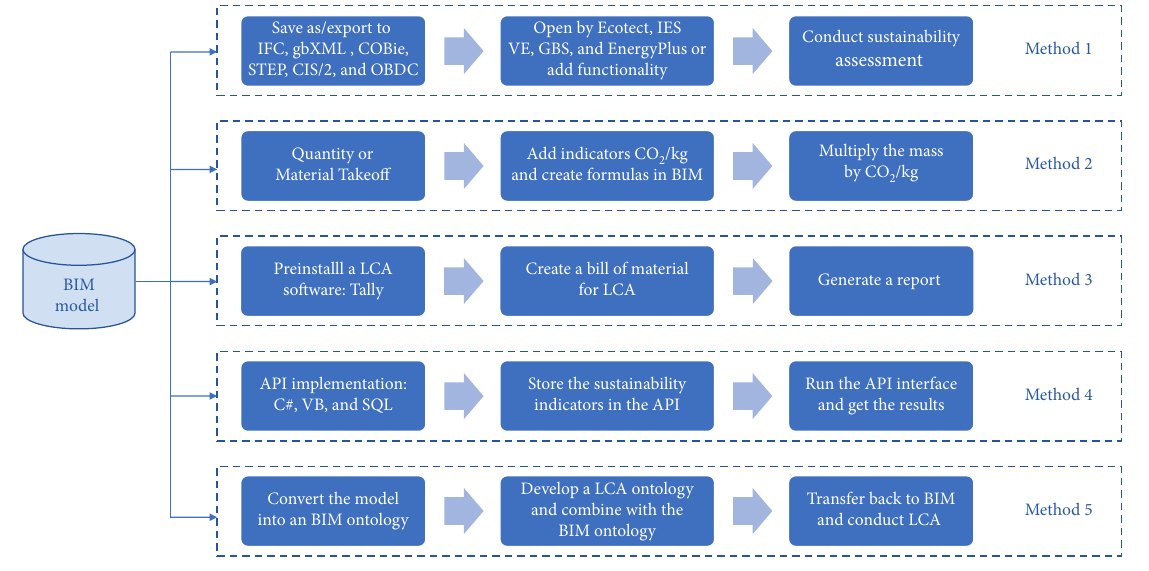
Figure 5: Summary of SSD methods with the integration of